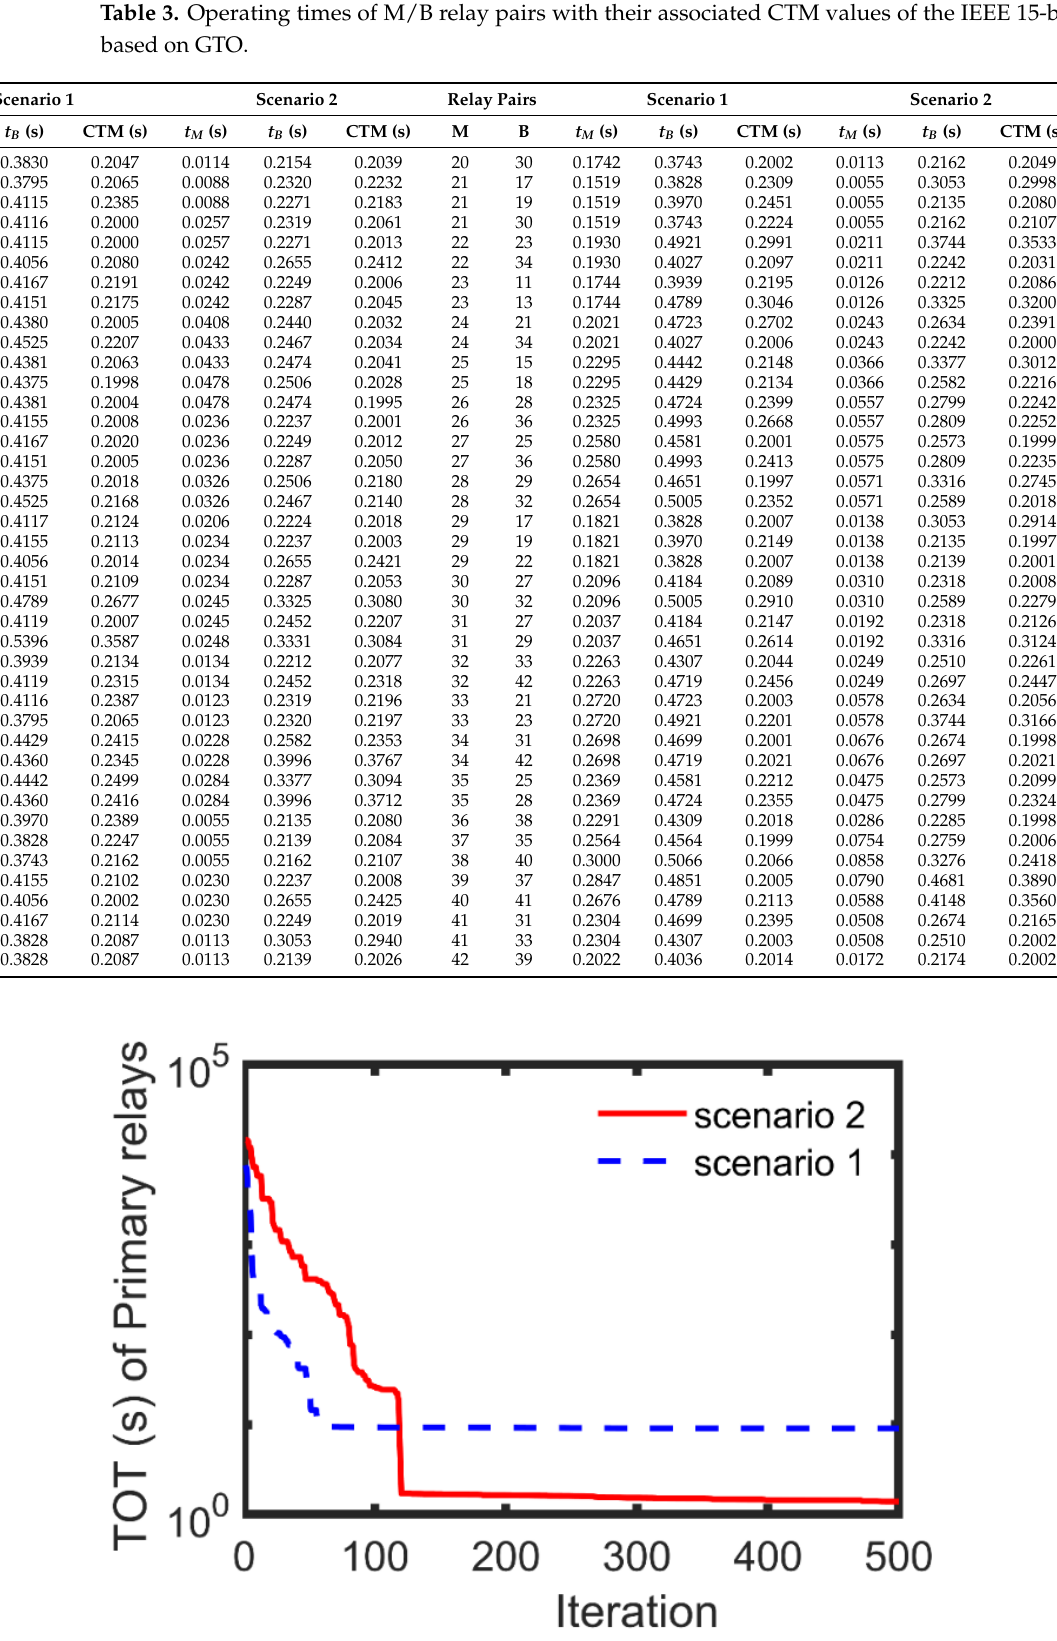
Figure 4. FOF convergence of the IEEE 15-bus network using GTO. Table 4. TOT comparison with other algorithms of the IEEE 15-bus.